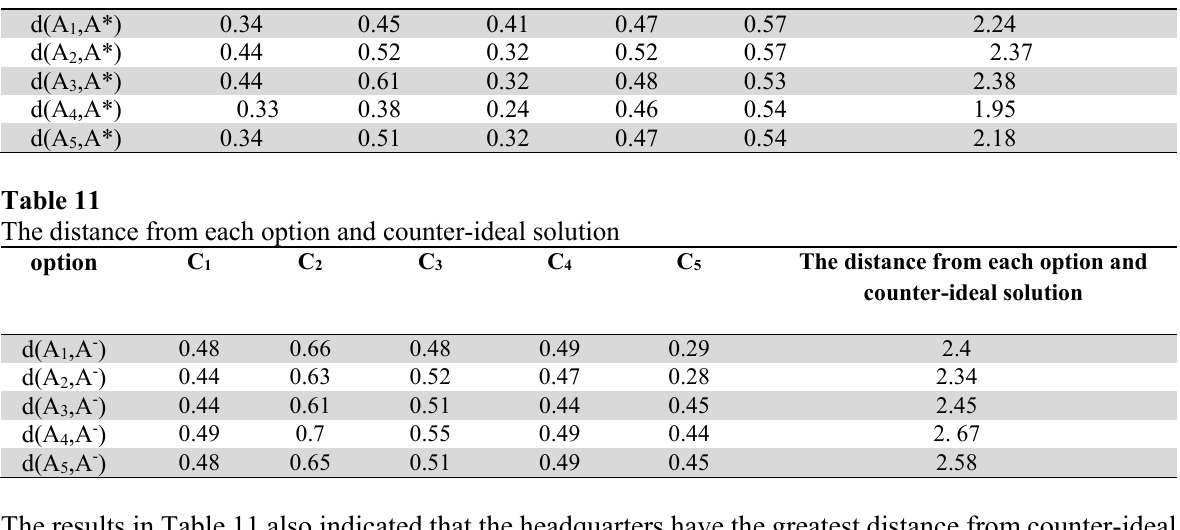
from the ideal solution